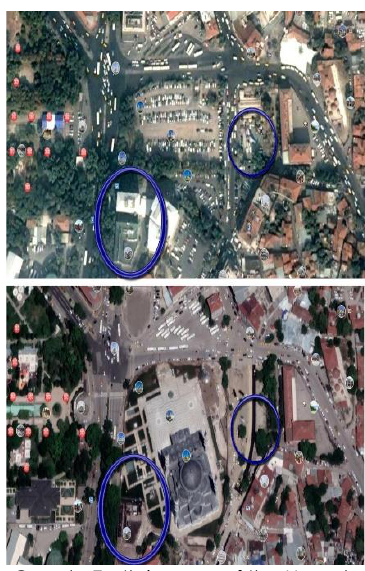
Figure 5: Google Earth images of the Hergelen square including the places of the Bank of Municipalities and Hajek’s sculpture in 2007 (above) and in (2017) below.